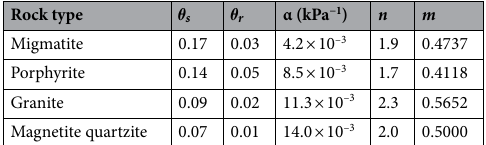
Table 5. Fitted hydraulic characteristics.